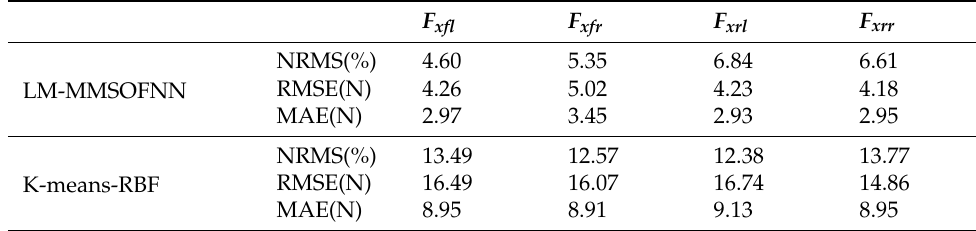
Table 8. Longitudinal tire force estimation errors of LM-MMSOFNN and K-means-RBF.